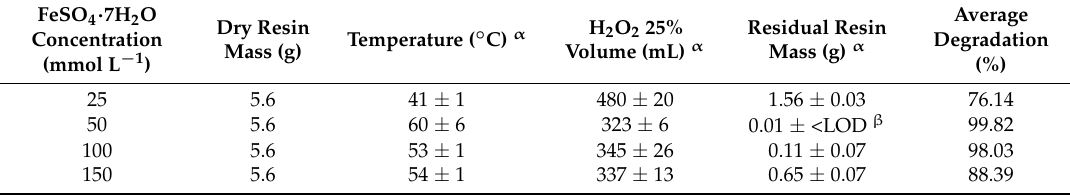
Table 2. Residual resin masses after the oxidation process under different temperatures and volumes of hydrogen